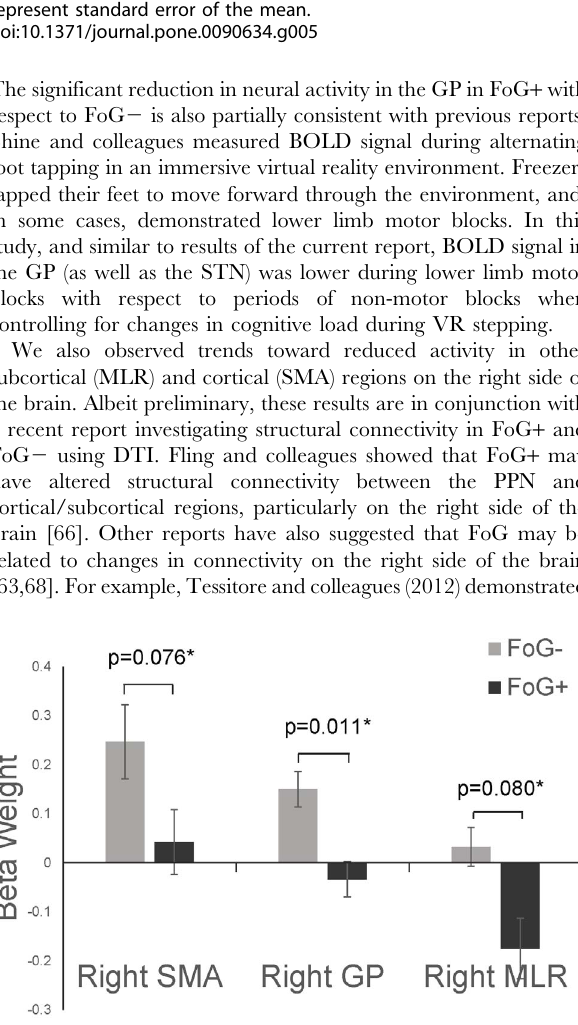
Figure 6. Mean beta weights (with respect to rest) for FoG 2 and FoG + during imagined walking in the right SMA, right GP, and right MLR. Error bars represent standard error of the mean. *ANCOVA group differences after correcting for MDS-UPDRS and gait imagery speed. doi:10.1371/journal.pone.0090634.g006 PLOS ONE |